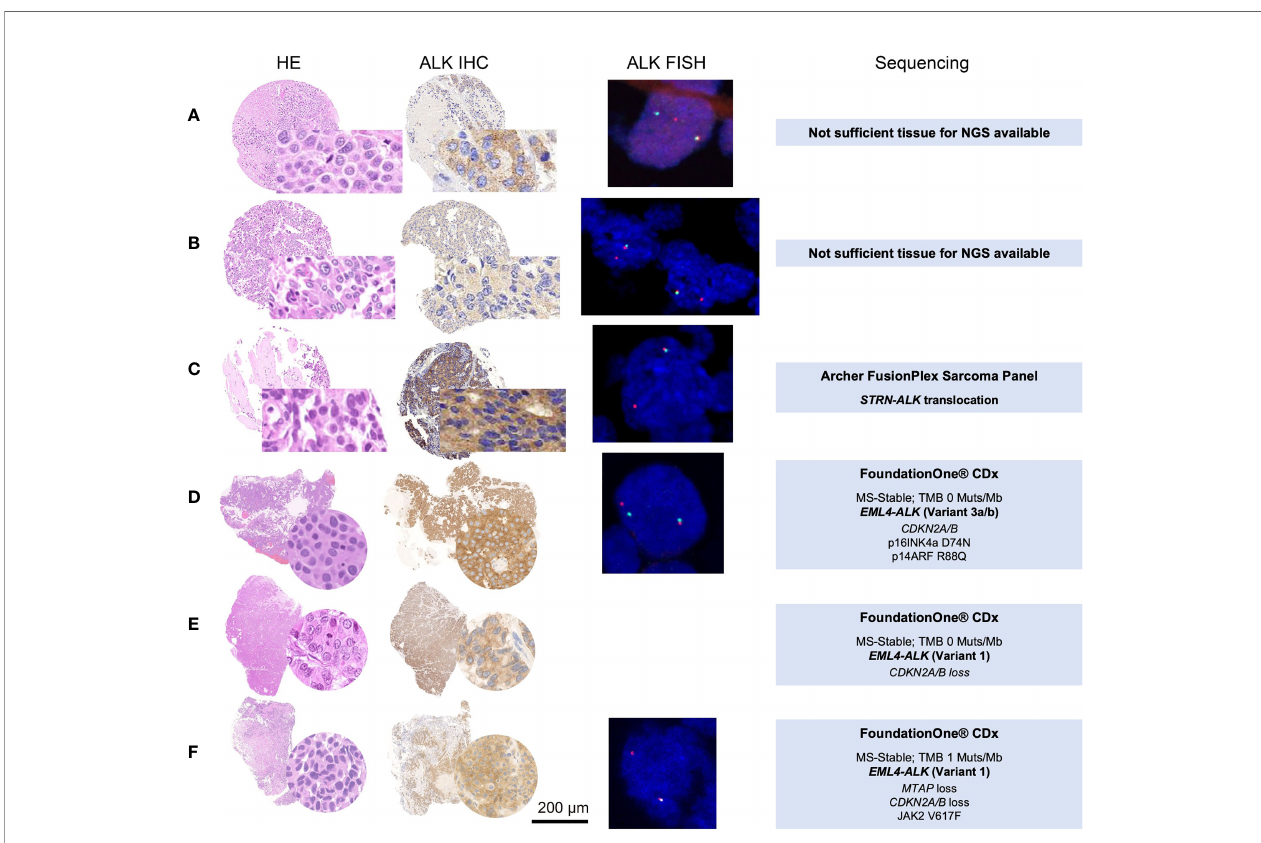
FIGURE 2 | HE, ALK IHC, ALK FISH, and NGS sequencing data of the fi ve ALK FISH-positive cases. Panels (A , D , E , F) were diagnosed as LCNEC, whereas (B , C) were evaluated as (AC). IHC was scored as 2+ (A) , 1+ (B) , and 3+ (C – F) . ALK FISH break-apart probes revealed aberrant staining patterns (A , D) one fused and one split red and green signal; (B , D , E) one fused and one single red signal) consistent with ALK rearrangements. In three cases (C – F) , the material was suf fi cient to perform NGS, con fi rming two times an EML4-ALK translocation (D) Variant 3a/b; (E , F) Variant 1) and one time an STRN-ALK translocation (C) . HE, hematoxylin – eosin; ALK, anaplastic lymphoma kinase; IHC, immunohistochemistry; FISH, fl uorescence in situ hybridization; NGS, next-generation sequencing. Scale bar 200